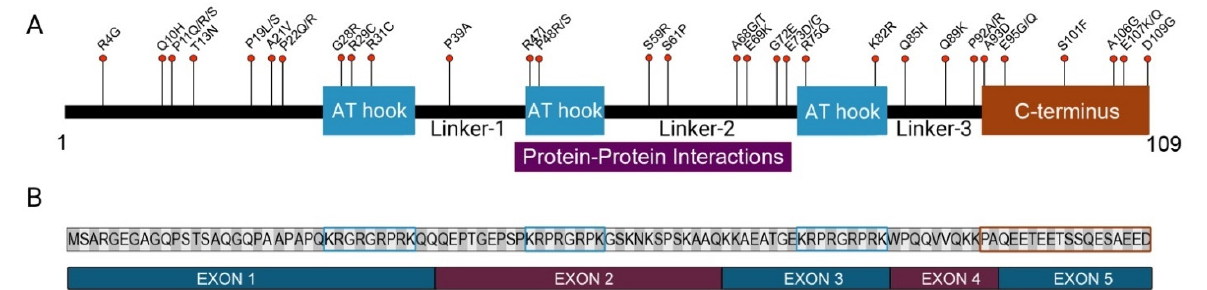
Figure 2. Distribution of encoded alterations of HMGA2. ( A ) Schematic depicting the amino acid position (red) of encoded alterations that are predicted to be possibly/probably damaging (PolyPhen-2) or deleterious (SIFT). Amino acids are indicated by their single letter code, numbers denote the amino acid position in the HMGA2 protein. ( B ) Distribution of the complete amino acid sequence (top) and exon positions (bottom) of the HMGA2 protein. AT hooks amino acid sequences (KRGRGRPRK, KRPRGRPK and KRPRGRPRK, respectively) are highlighted in blue and the C-terminus amino acid sequence (PAQEETEETSSQESAEED) in orange.